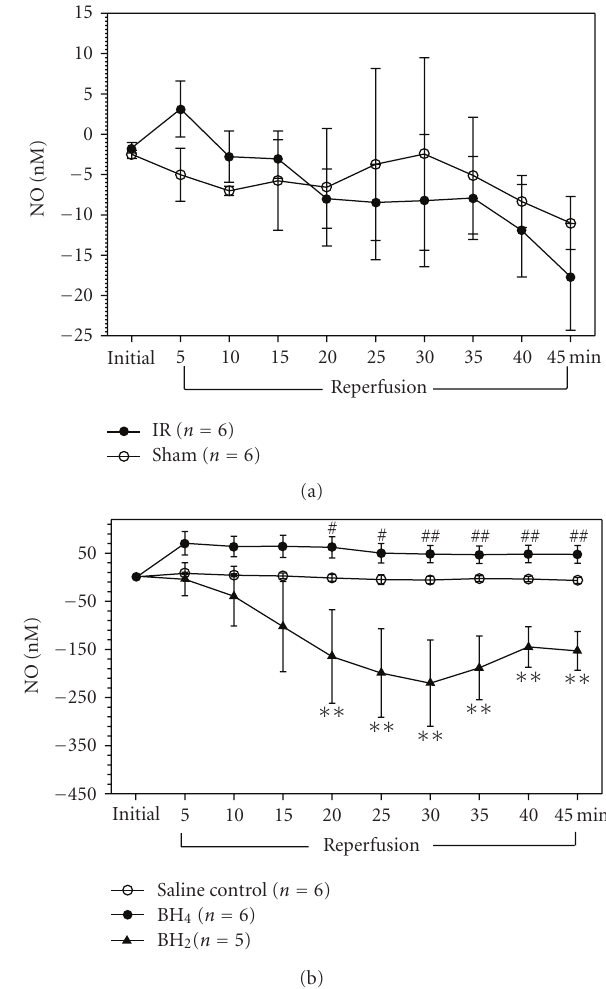
Figure 3: Measurement of NO (nM) release from rat femoral veins during reperfusion in the saline control group and BH 4 - or BH 2 - treated group. (a) NO (nM) releases from rat sham and I/R femoral veins during reperfusion in the saline control group. Anesthetized rats were given saline via tail vein at the beginning of reperfusion ( n = 6) . There was a slight decrease in NO release from I/R veins compared to sham veins after 20 minutes of reperfusion. (b) The relative di ff erence in NO release between I/R and sham femoral veins in the saline control group ( n = 6), BH 4 (6.5mg/kg)-treated group ( n = 6), and BH 2 (4mg/kg)-treated group ( n = 5) . BH 4 or BH 2 was given via tail vein at the beginning of reperfusion. BH 2 treatment significantly decreased NO release from 20 minutes and throughout the rest of reperfusion. BH 4 treatment significantly increased NO release from 20 minutes to 45-minute reperfusion compared to BH 2 treatment. ( ∗ P < . 05, ∗∗ P < . 01 from saline control group; # P < . 05, ## P < . 01 from BH 2 -treated group).